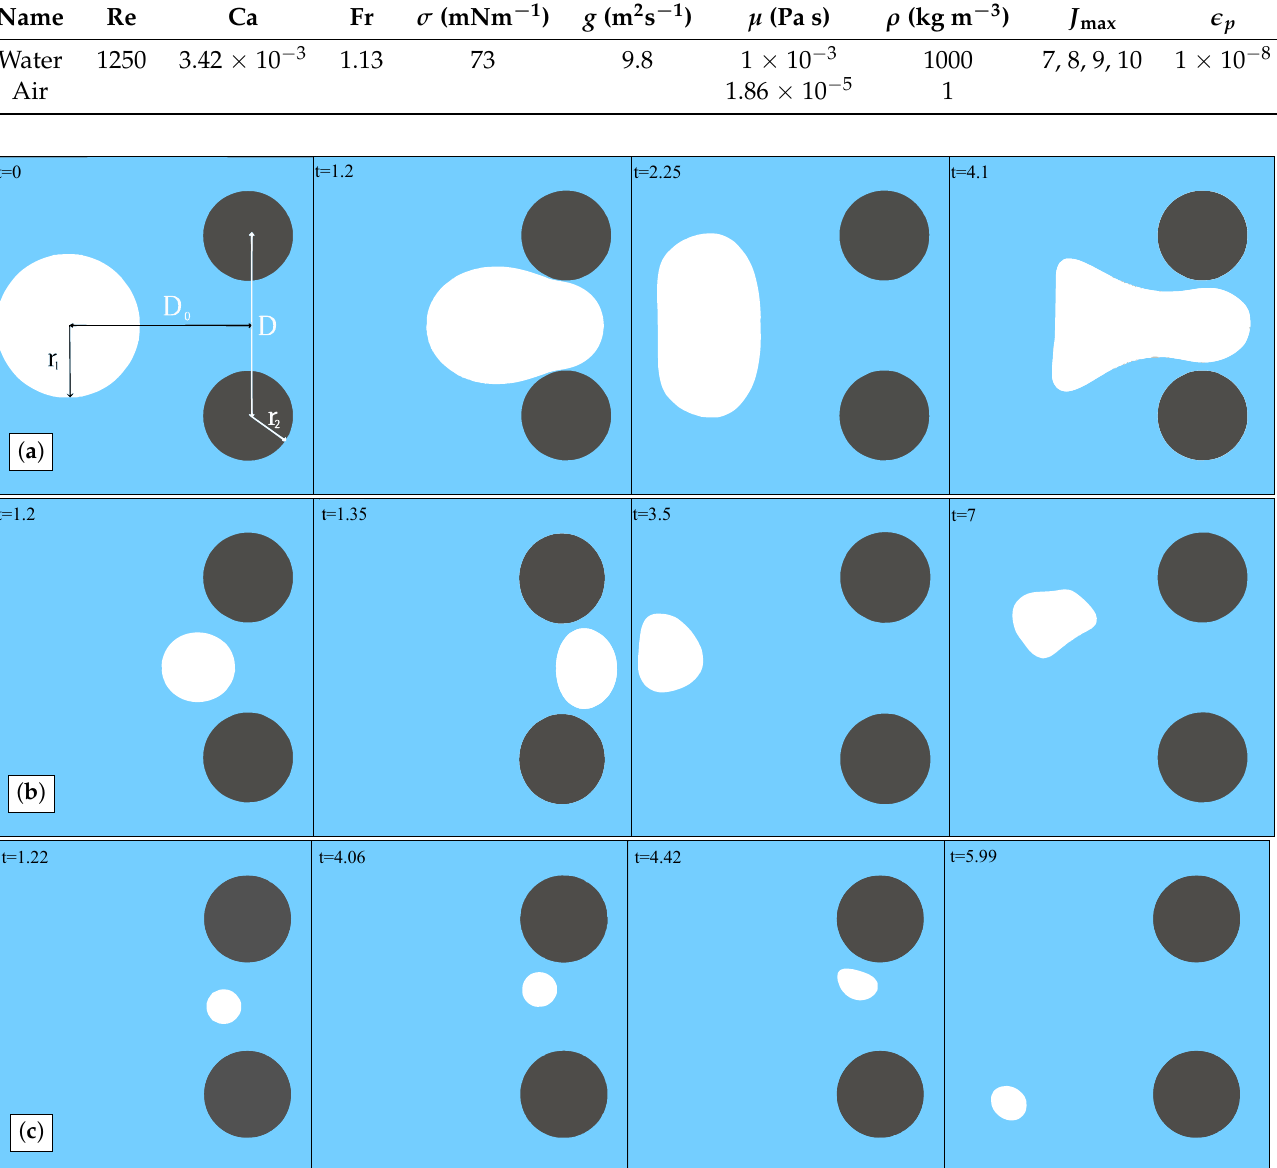
Table 2. Physical properties of the fluids and numerical parameters used in the simulation of the bubble passing between two cylinders. Here, J max is the maximum level of refinement, and (cid:101) p is the tolerance of the Poisson solver.